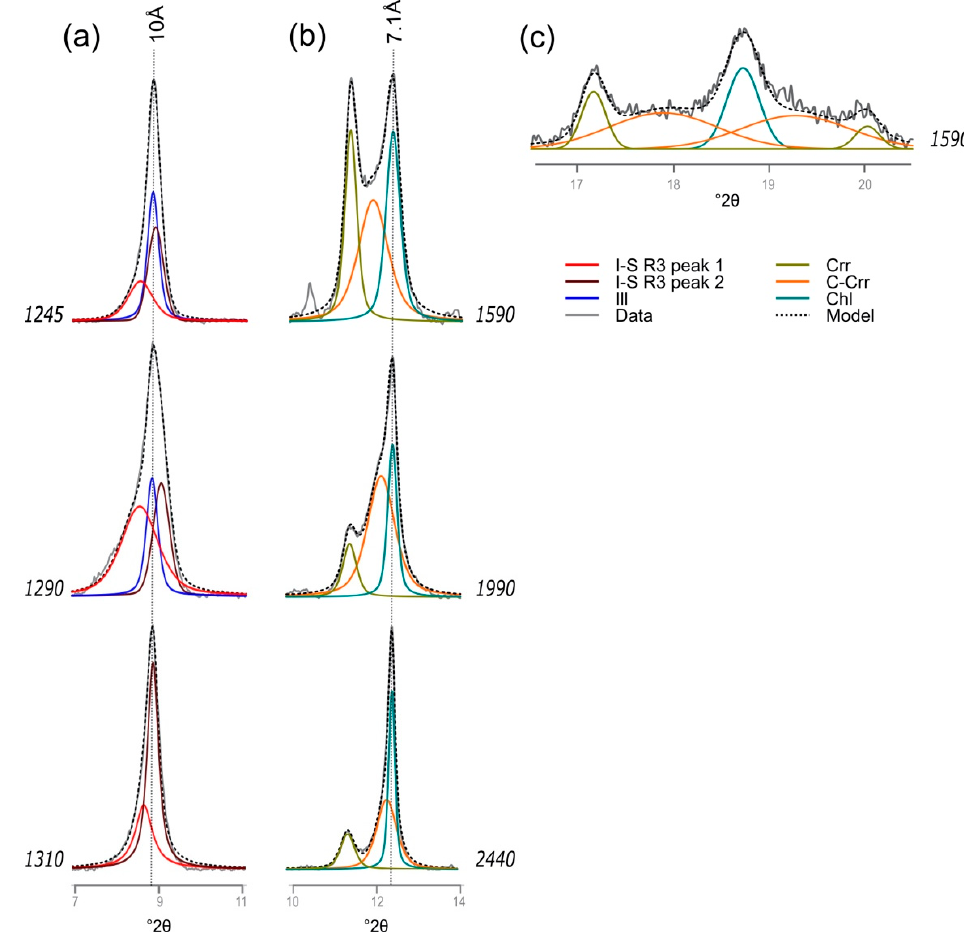
Figure 4. Deconvolution of the X-ray diffractograms of EG-saturated oriented powder (<5 μ m clay fraction). ( a ) Illitic peak (7–11 °2 θ domain) of the samples CP-6A 1245 (upper FZ associated with positive T anomaly), 1290 (edges of FZ), and 1310 (lower FZ associated with negative T anomaly). Ill: illite, I-S: ordered illite/smectite mixed layer. ( b ) Deconvolution of the chloritic peak (10–14°2 θ domain) of the samples CP-4A 1590 (corrensite dominant), 1990 (C-Crr dominant), and 2440 (chlo- rite dominant). Chl: chlorite, Crr: corrensite, C-Crrl: chlorite–corrensite mixed layer. ( c ) Deconvo- lution of the chloritic peak (16–21 °2 θ domain) of the sample CP-4A 1590.